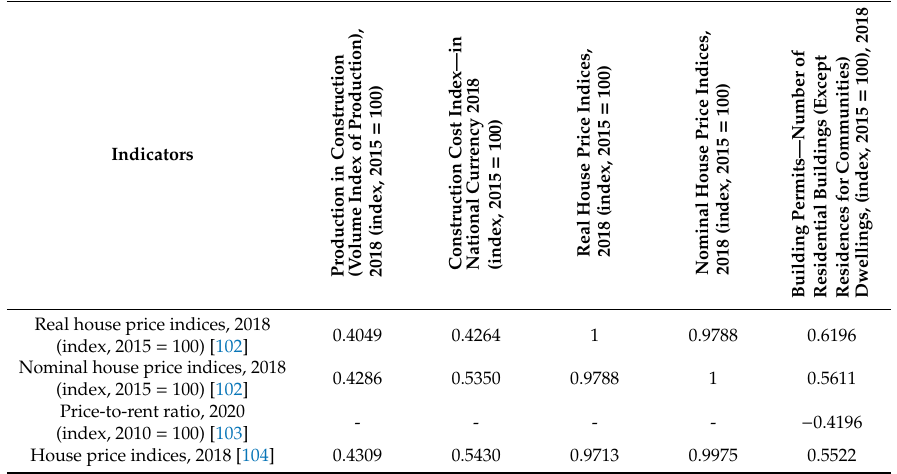
Table 3. The correlation between the construction and housing price indices of the 25 EU countries, the UK and